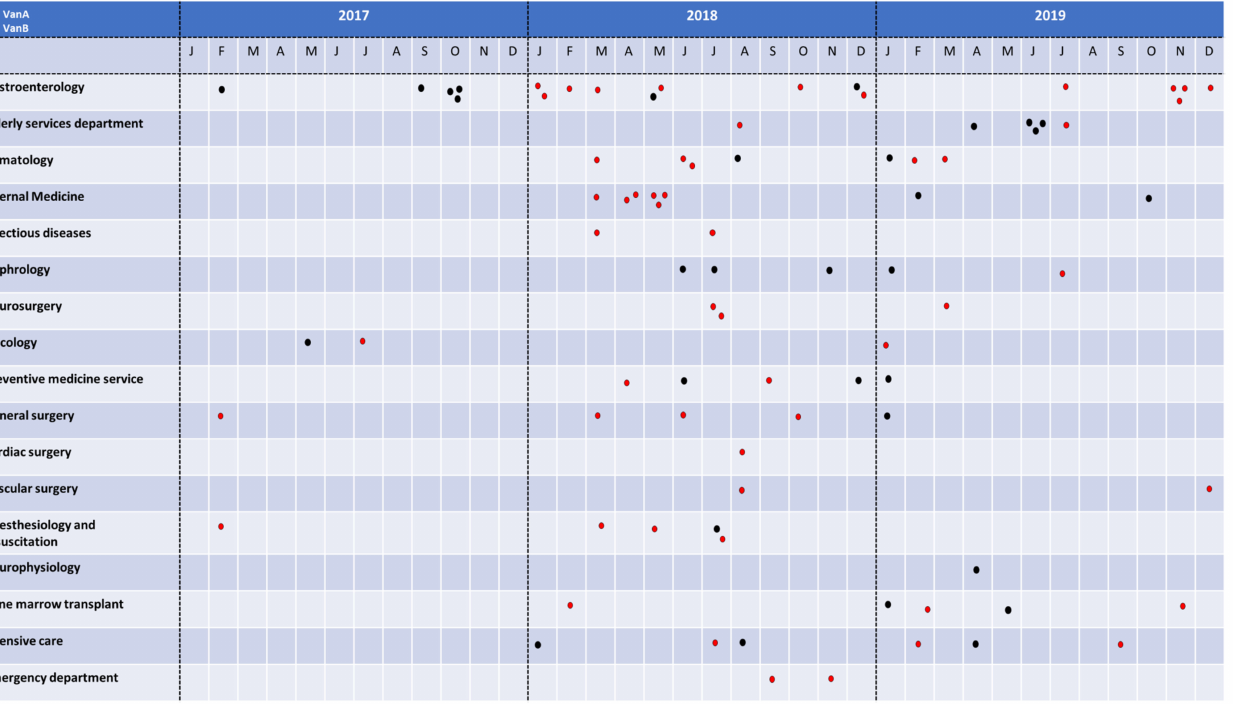
Figure 1. Distribution of the E. faecium isolates analyzed in this study by hospital departments and date. VanA E. faecium isolates are shown with black dots and VanB isolates with red